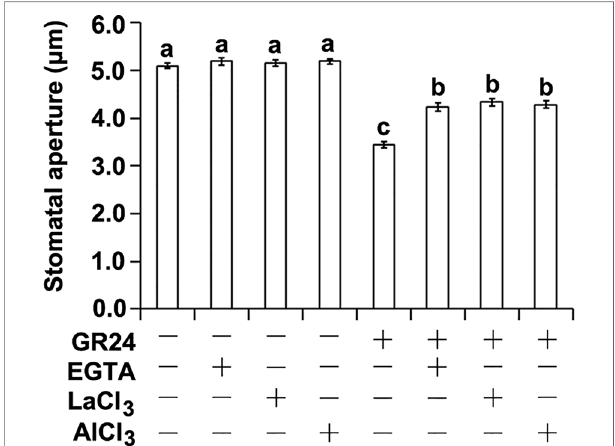
FIGURE 1 | The effects of Ca 2+ chelator and channel inhibitors on strigolactone-induced stomatal closure. Leaf epidermal peels of WT plants with open stomata were exposed to either the MES-KCl buffer with (+) or without ( – ) 1 m M GR24, 2 mM EGTA, 1 mM LaCl 3 , or 1 m M AlCl 3 . The stomatal apertures were measured for different treatments. Data are means ± SE of three independent experiments Bars with different letters represent statistically signi fi cant